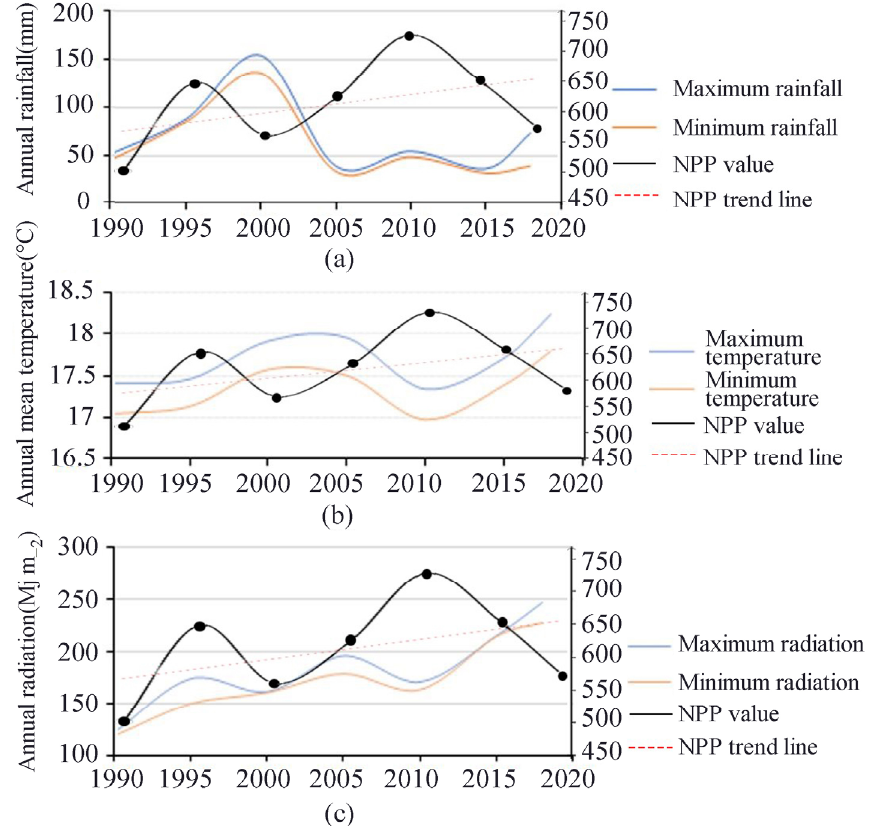
Figure 5. Changes in annual radiation ( a ) annual average temperature area ( b ) annual rainfall ( c ) of the study area. Table 5. Change of land use area and NPP from 1990 to 2018.